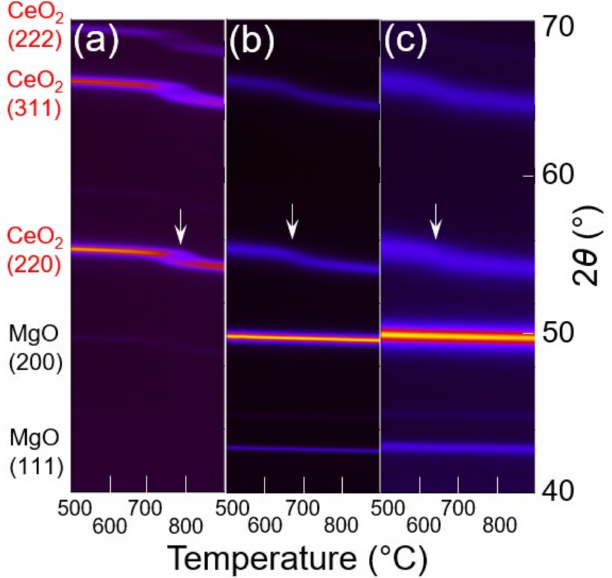
Figure 7. In situ XRD patterns of ( a ) CeO 2 , ( b ) 0.05-CeO 2 /MgO(air), and ( c ) 0.05-CeO 2 /MgO(dry). A Co X-ray source and an Fe filter were used for the measurements. White arrows indicate the inflection points observed on the (220) peaks of CeO 2 . The unassigned weak peaks were attributed to the diffraction of Co K- β